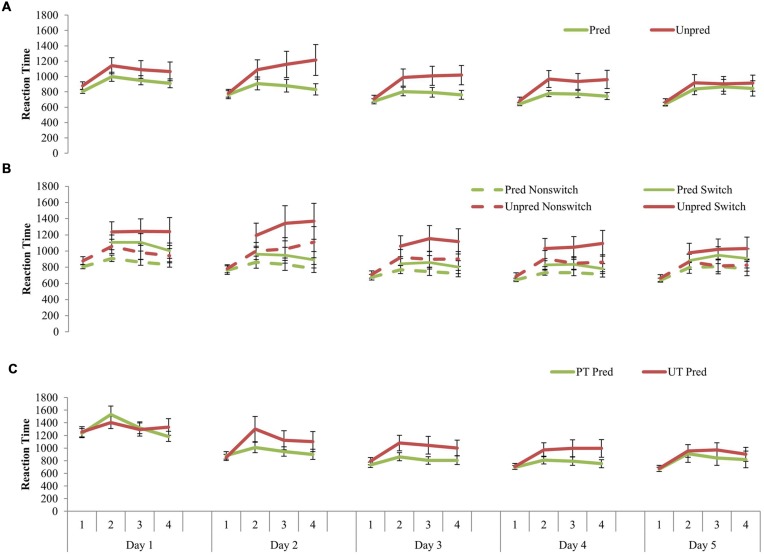
(A) Training-related changes in probe retrieval across 5 days of training. The unpredictable group became more similar to the predictable group on the final day of training (Day 5). (B) Training-related changes in probe retrieval for switch and non-switch trials across 5 days of training. Both training groups exhibited worse performance on the switch trials compared to the non-switch trials, even after 5 h of training. (C) Training-related changes in the comparison task after 5 days of training. The two groups did not differ. Error bars represent standard error of the mean. Pred, predictable; Unpred, unpredictable; PT, predictable training group; UT, unpredictable training group.